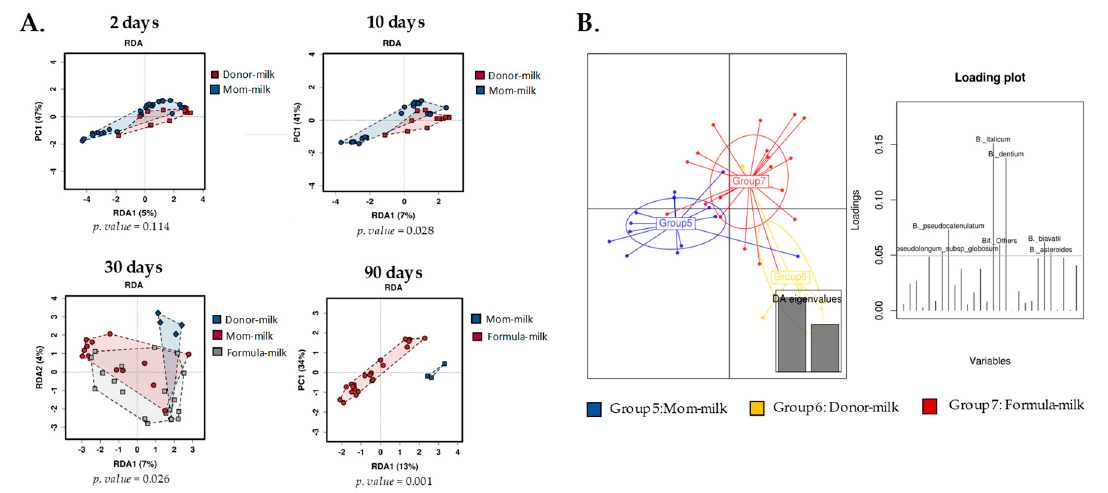
Figure 3. Bifidobacterium grouped based on feeding type. ( A ) Redundancy analysis (RDA) showing separation over time. ( B ) Discriminant analysis of principal components (DAPC) plot and loading plot at 30 days of life. Colors and groups are explained in each figure.